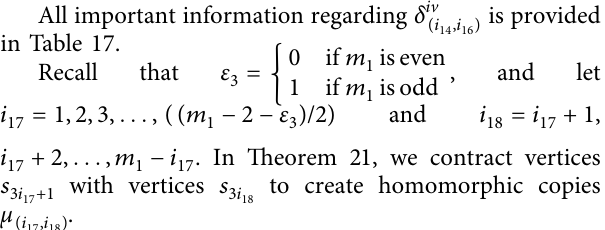
, t ) 3 i 10 + 1 3 i 11 6